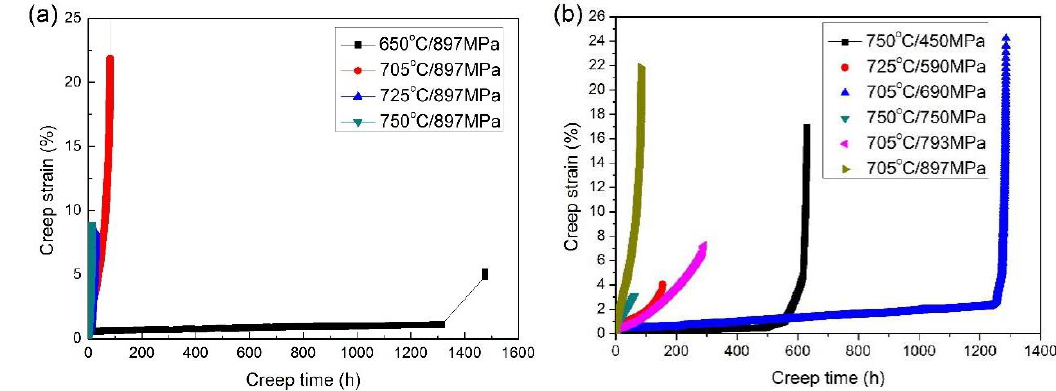
Figure 11. Creep curves of IFed alloy under different stress and temperature conditions: ( a ) 897 MPa/650 – 750 °C and ( b ) 450 – 897 MPa/705 – 750 °C.